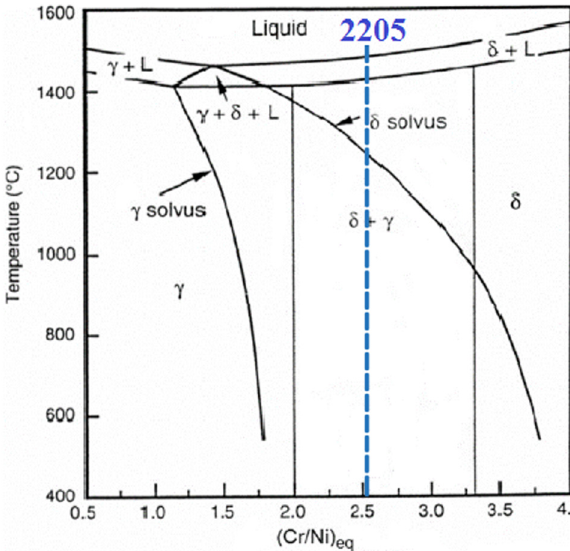
Figure 3: Pseudo binary diagram of stainless steel [ 34 ]